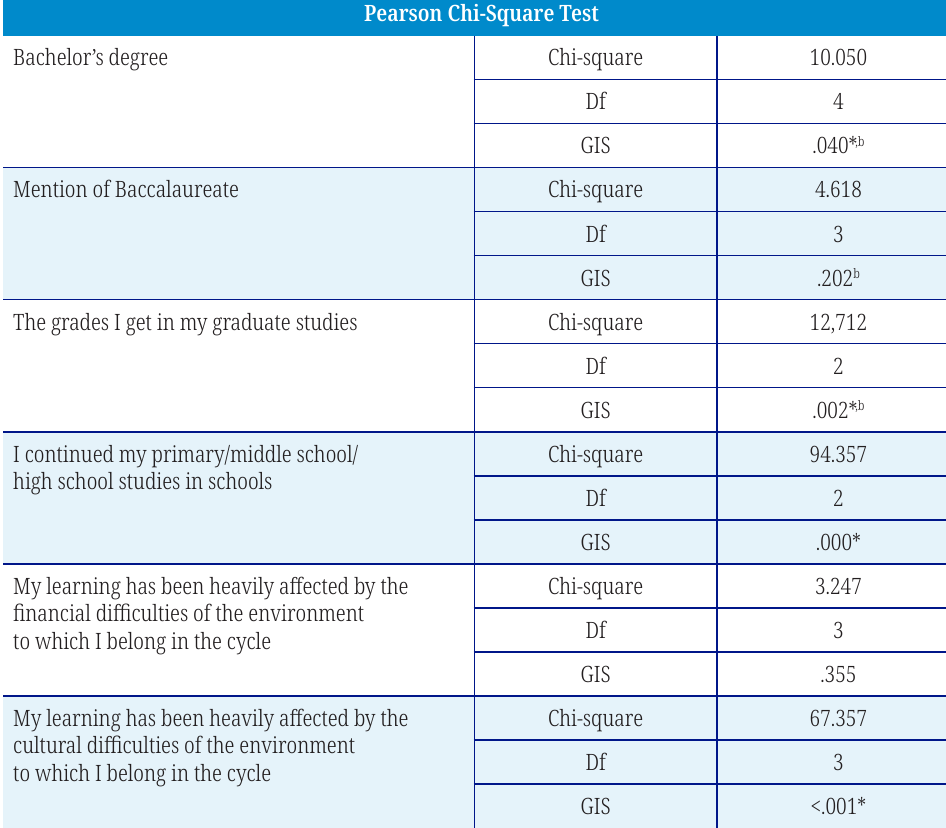
Table 4. Pearson chi-square test: academic level of public/private university